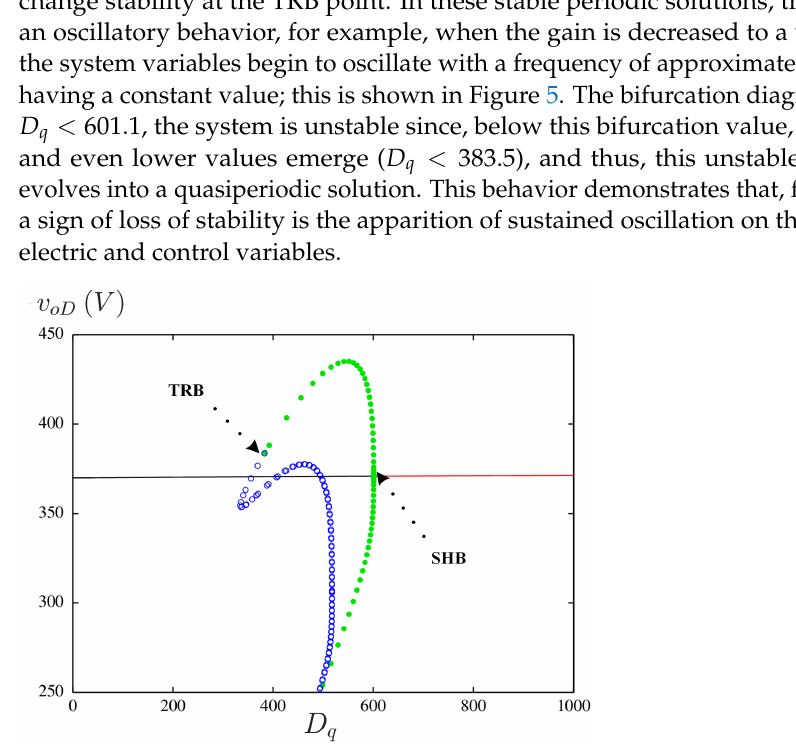
Figure 4. Bifurcation diagram by varying D q : stable solutions in red, unstable solutions in black, stable periodic solutions in green, and unstable periodic solutions in blue.